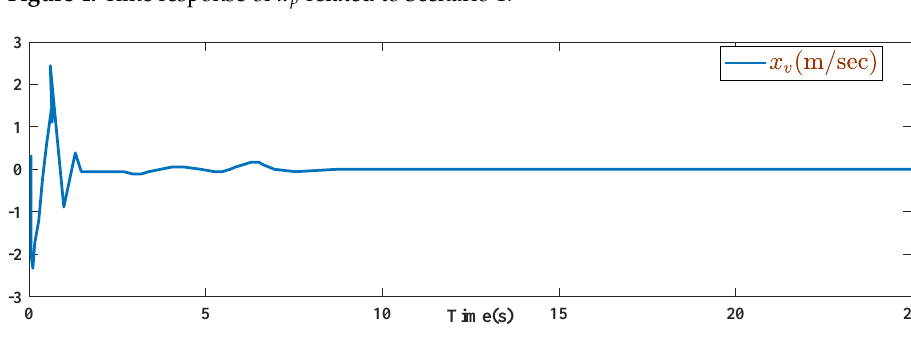
Figure 4. Time response of x p related to Scenario 1.